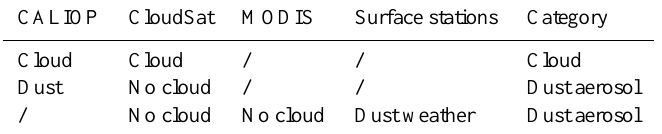
Table 2. Independent cloud and dust aerosol differentiation method using CALIOP, CloudSat, MODIS and Surface stations observations.